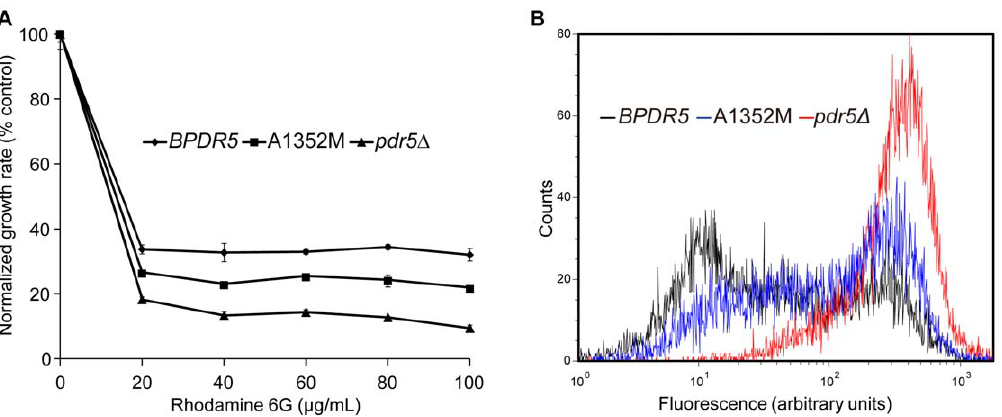
Figure 3. Pdr5p-mediated efflux of rhodamine 6G in BPDR5 and mutant cells. (A) Rhodamine 6 G resistance of BPDR5 ( % ), pdr5 D ( m ) and A1352 ( & ) mutants were compared in liquid culture as described in materials and methods. Growth in the absence of R6G was served as control. Growth at each concentration of R6G is shown as (% control). The mean values of three independent experiments are plotted and the error bars represent the S.D. (B) The transport capabilities of BPDR5 , pdr5 D and A1352M were compared with flow cytometry. The histogram derived from the CellQuest software depicts fluorescence intensities for BPDR5 (black), pdr5 D (red) and A1352M (blue).